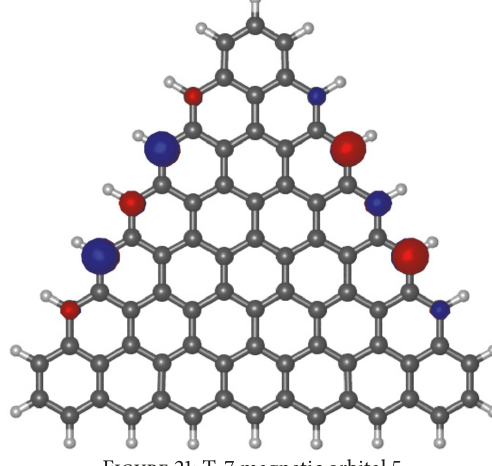
Figure 20: T 7 magnetic orbital 4.